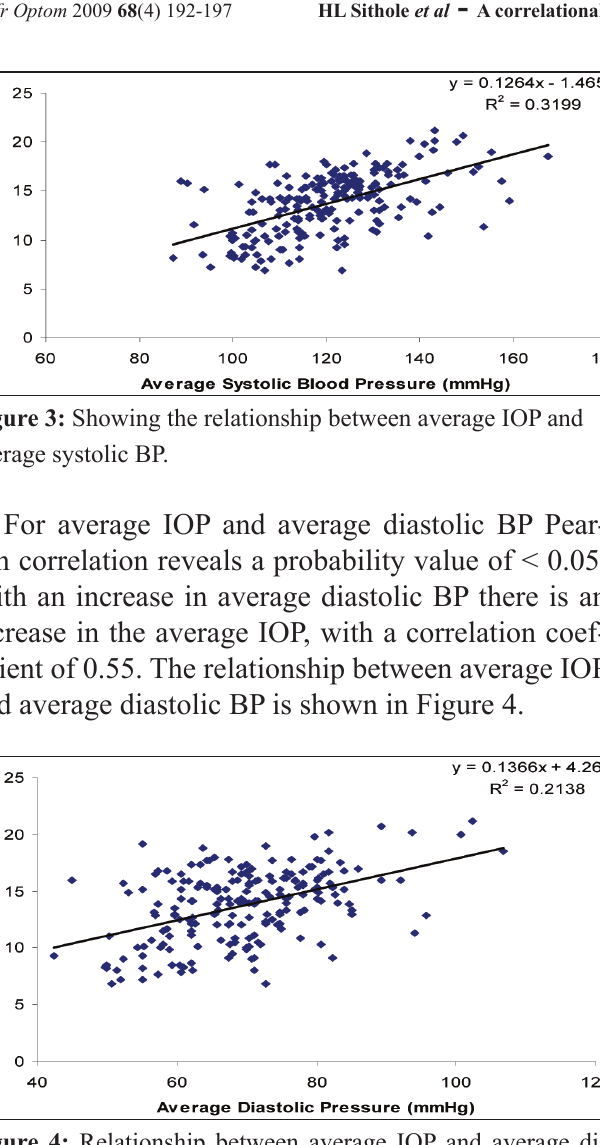
Figure 4: Relationship between average IOP and average di- astolic BP.